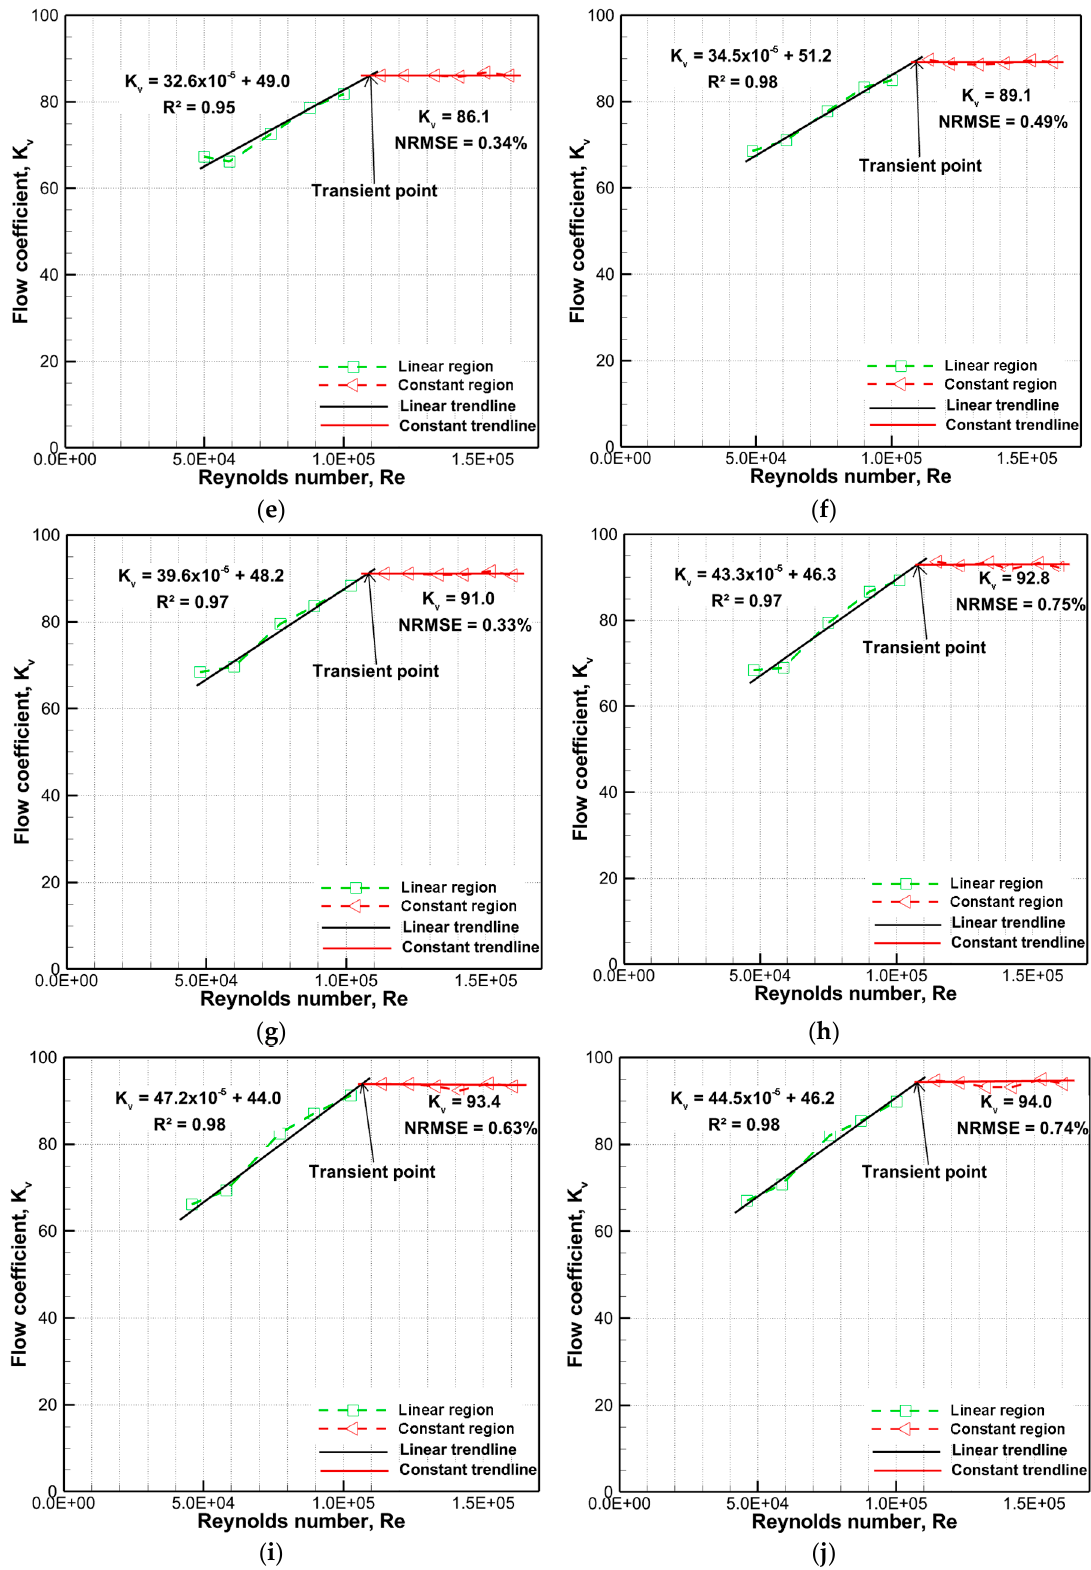
Figure 13. Linearity and constant characteristics of flow coefficient with Reynolds number. ( a ) 10% opening. ( b ) 20% opening. ( c ) 30% opening. ( d ) 40% opening. ( e ) 50% opening. ( f ) 60% opening. ( g )